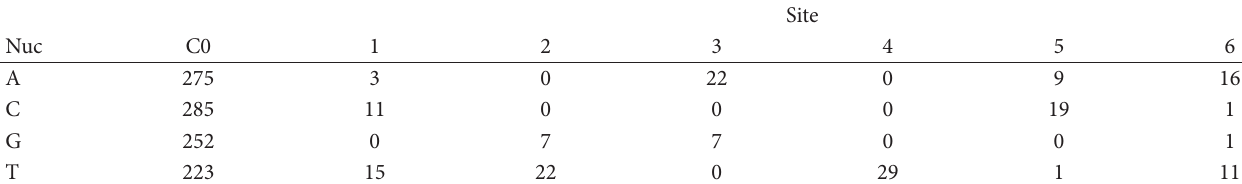
T 6: Final site-speci�c distribution of nucleotides from the 29 identi�ed motifs. Output from �AM�� [53,